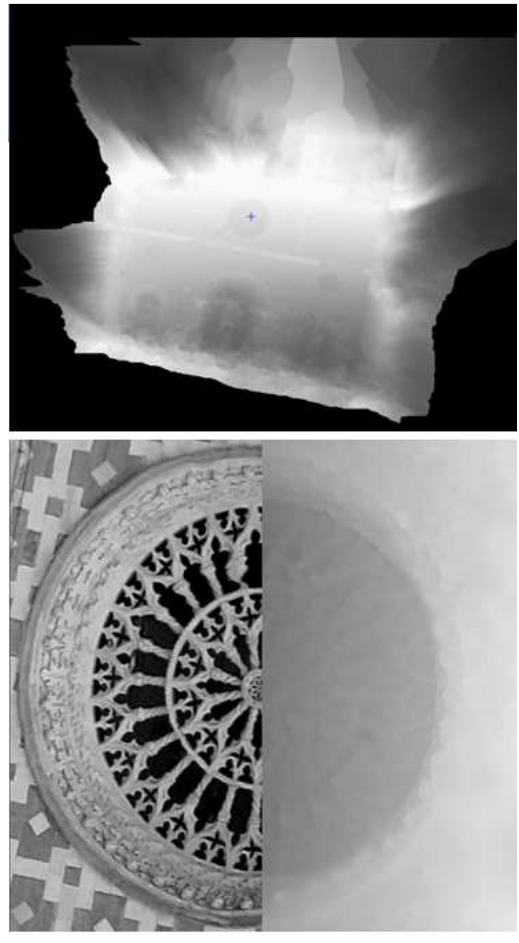
Figure 10. First test of DSM extraction from the